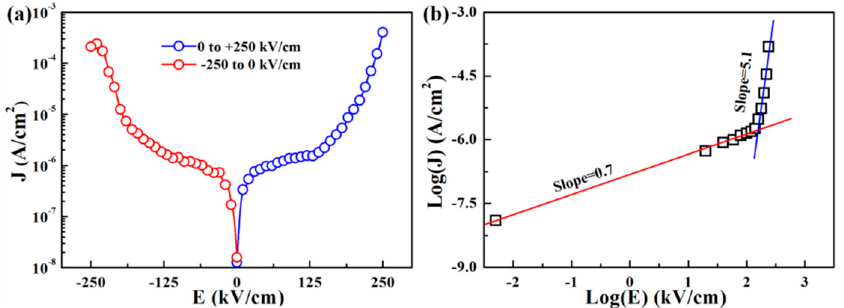
Figure 2. Leakage current density vs. applied electric fields (a) and log(J) vs . log(E) (b) for (110) NBT film.